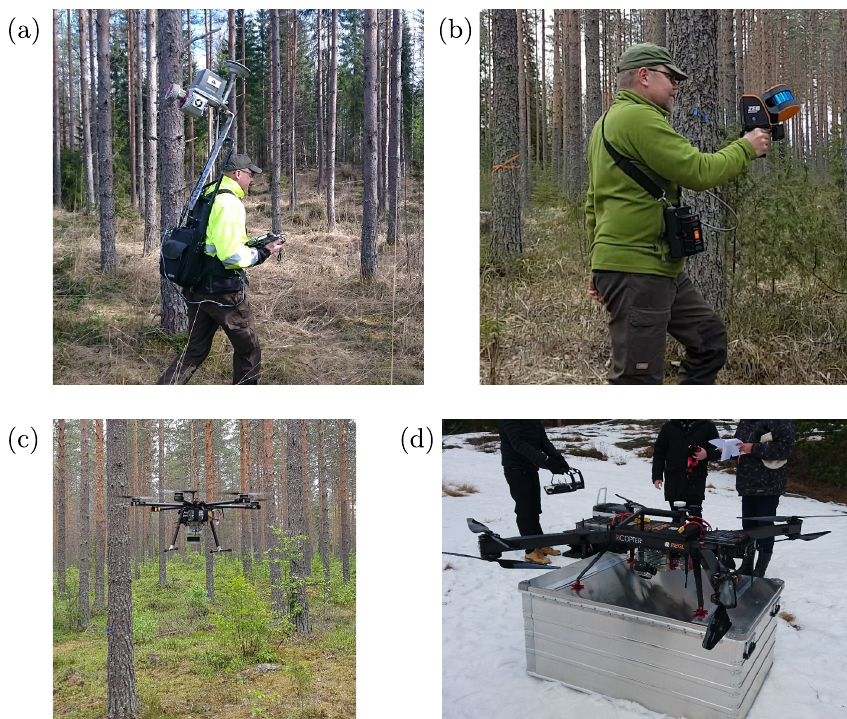
Figure 3. Photographs of ( a ) the backpack mobile laser scanning unit (BP-MLS-VUX1), ( b ) the handheld ZEB-Horizon laser scanner (HH-MLS-ZEB), ( c ) the under-canopy UAV laser scanning system (UC-UAV-LS), and ( d ) the RiCopter laser scanning system (UAV-LS-RiCOP). Table 3. Technical specifications of the backpack laser scanning system, the under-canopy unmanned aerial vehicle (UAV) laser scanning system, and the handheld laser scanning